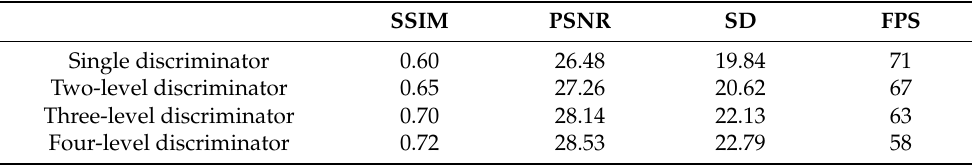
Table 7. Comparison of the effectiveness of the discriminant networks.